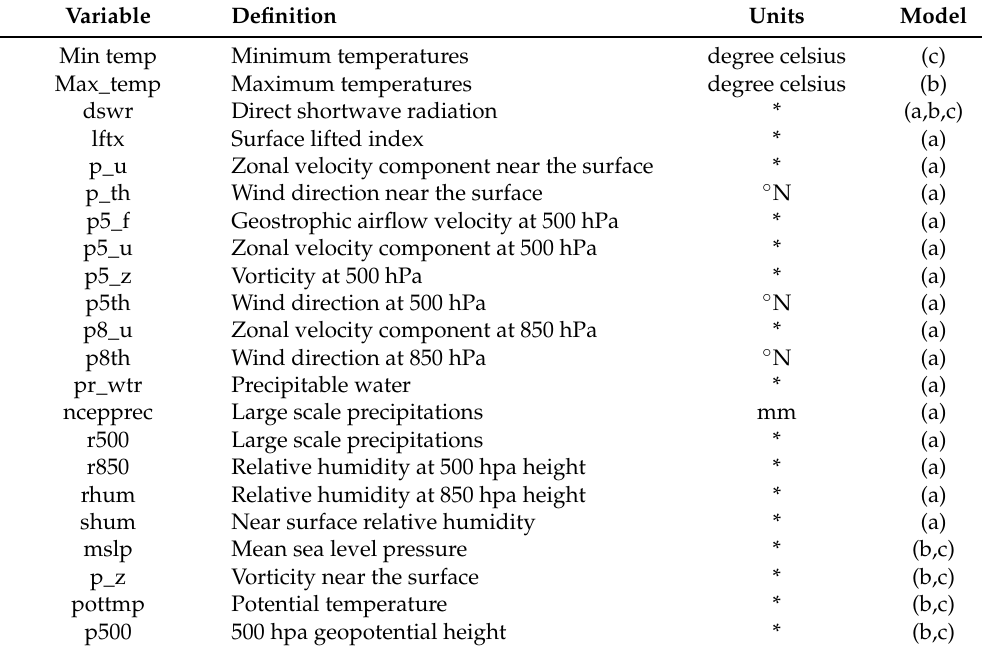
Table 2. Definition of variable names, their units and corresponding models. ◦ N denotes North direction, mm denotes Millimeter, and * denotes dimensionless Z-score. (a) denotes monthly pre- cipitation model, (b) denotes monthly minimum temperatures and (c) denotes monthly maximum temperatures